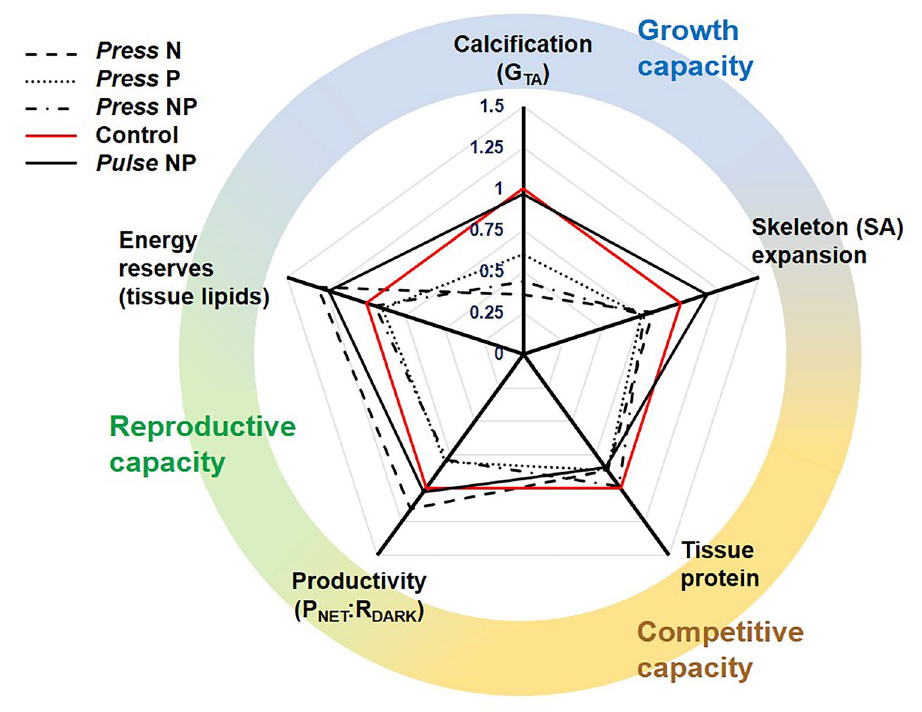
Figure 3. Conceptual summary depicting changes or trade-offs in survival strategy of Acropora intermedia under different treatments of elevated ammonium (N) and/or phosphate (P), as permanent ( press ) or temporary ( pulse ) elevations. To create this plot, the average performance for each physiological parameter (calcification, skeleton expansion, tissue protein, productivity, or stored energy reserves) in a treatment is calculated and represented as a fraction of the respective parameter for the control treatment, which is always fixed at 1 (red line). The three main strategies of long-term colony viability are represented on the colored circle: growth (blue), competition (orange), and reproduction (green). Here, growth is defined as the combined capacity to amass skeleton and energy reserves, competition as the capacity to occupy or consolidate physical space on the reef, and reproduction as the capacity to produce offspring. Calcification was calculated as the 24 h-average of day and nighttime calcification based on a 12–12 h day–night